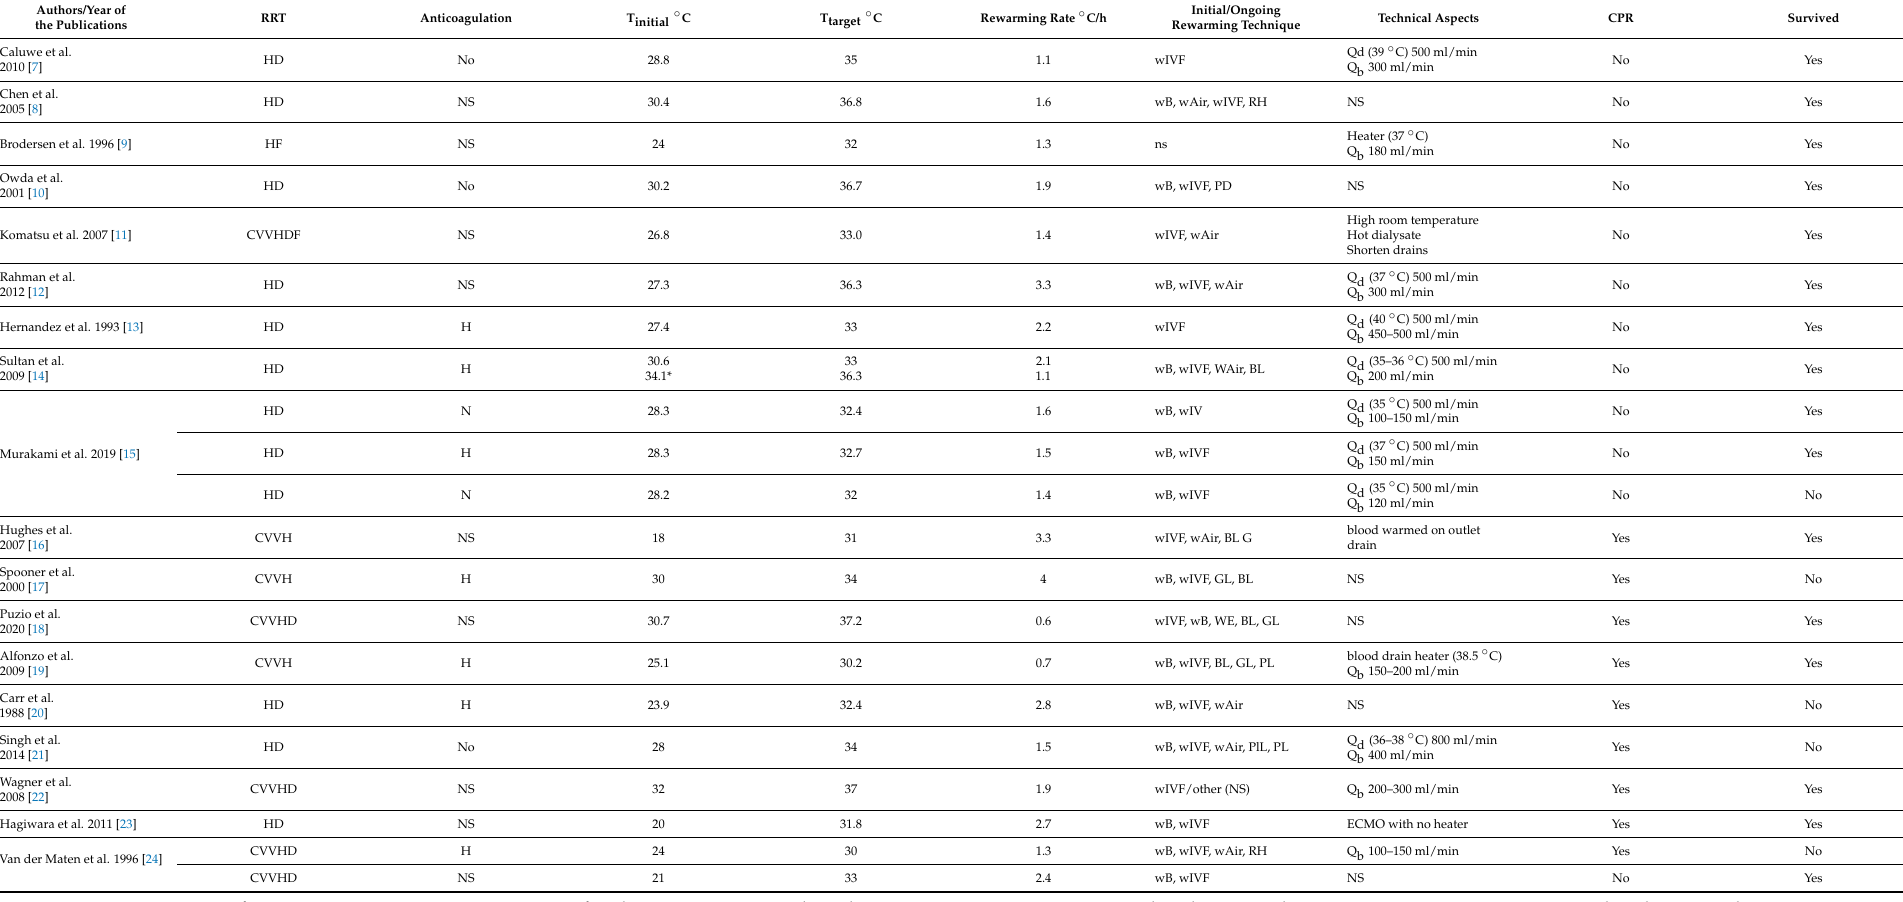
Table 2. Review of hypothermia management with RRT in published case